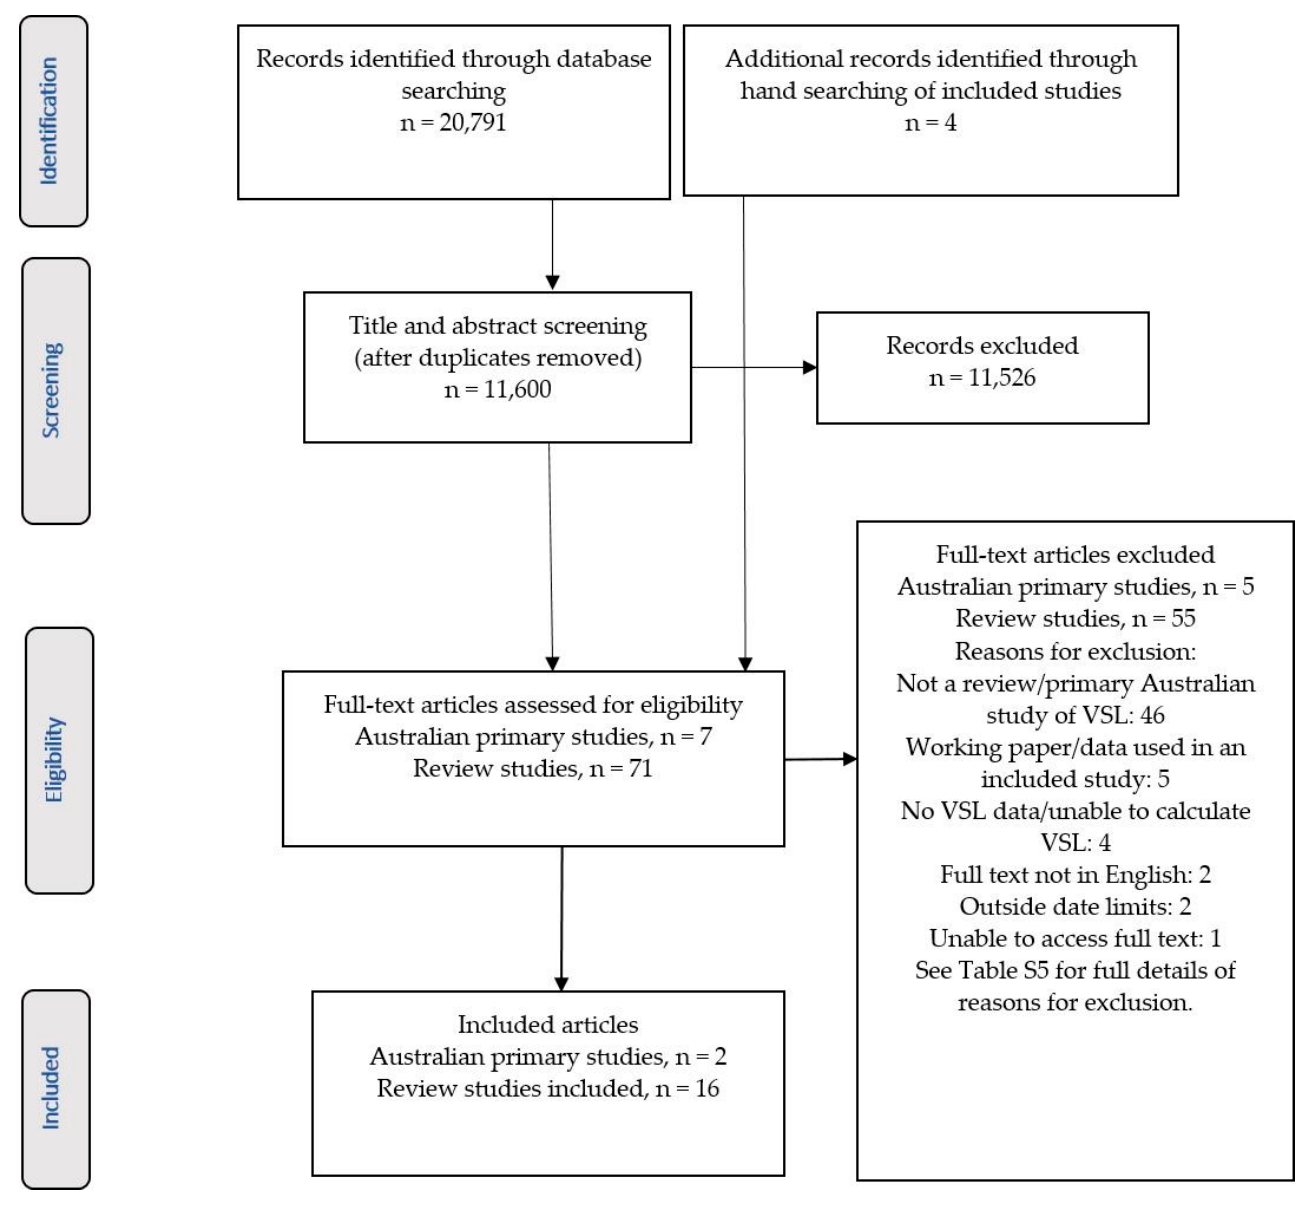
Figure 1. PRISMA flow diagram of article selection process.